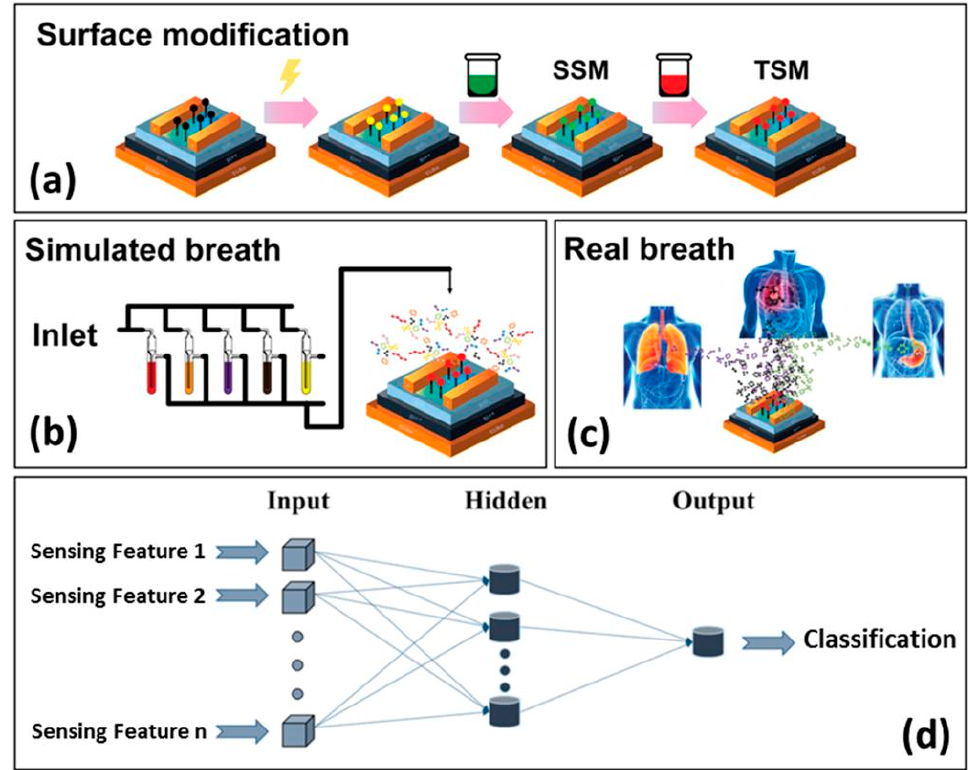
Figure 9. Schematic of ( a ) surface modification of SiNW FET sensors (SSM, single-step modification; TSM, two-step modification); ( b ) sensor exposure to synthetic samples of potential organic volatile biomarkers for each disease (asthma/COPD, LC, GCa); ( c ) sensor exposure to real breath samples of patients with selected diseases, in comparison to HC; ( d ) ANN analysis representation. Increased accuracies were obtained for the discrimination of GCa vs. LC and LC vs. asthma and COPD patients. Reprinted with permission from Ref. [43]. Copyright © 2016, American Chemical Society.